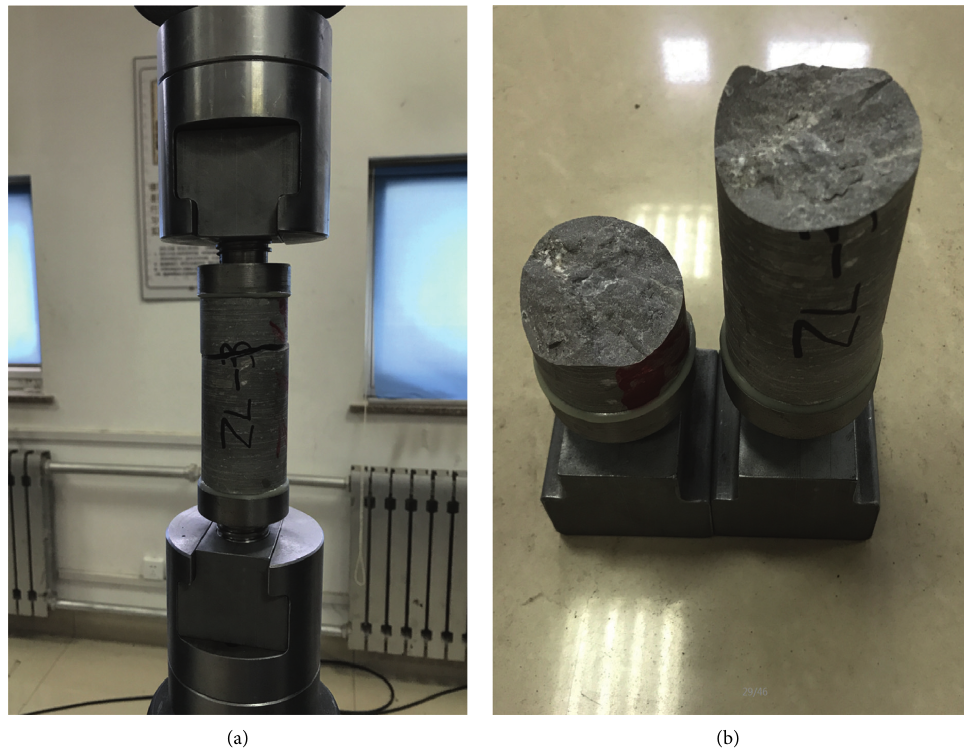
Figure 11: Failure modes of Yunnan limestone in the direct tensile